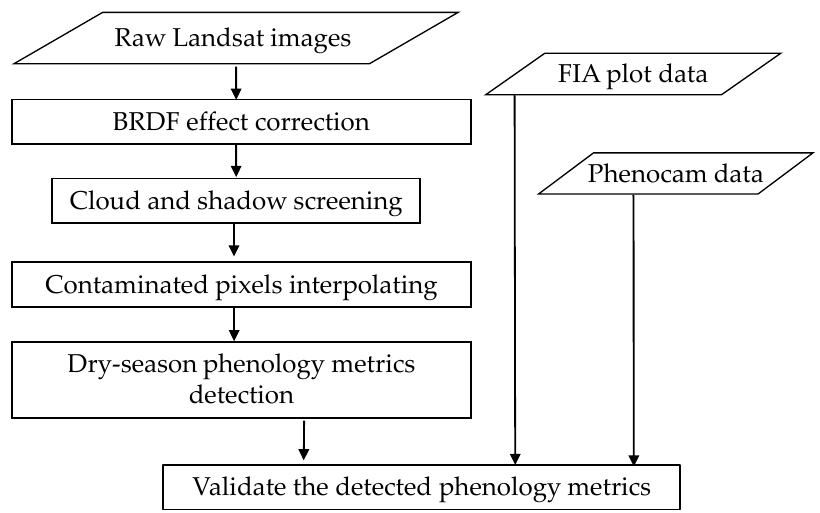
Figure 2. The flowchart of this study.